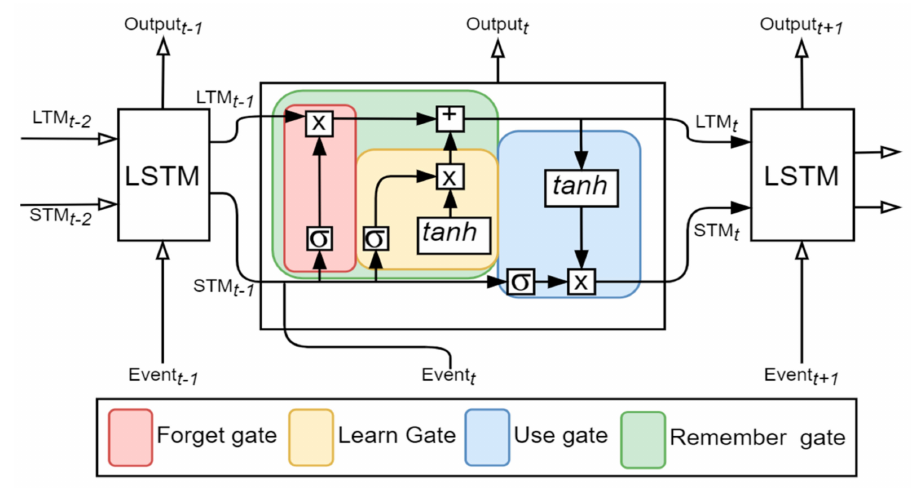
Figure 1. Architecture of